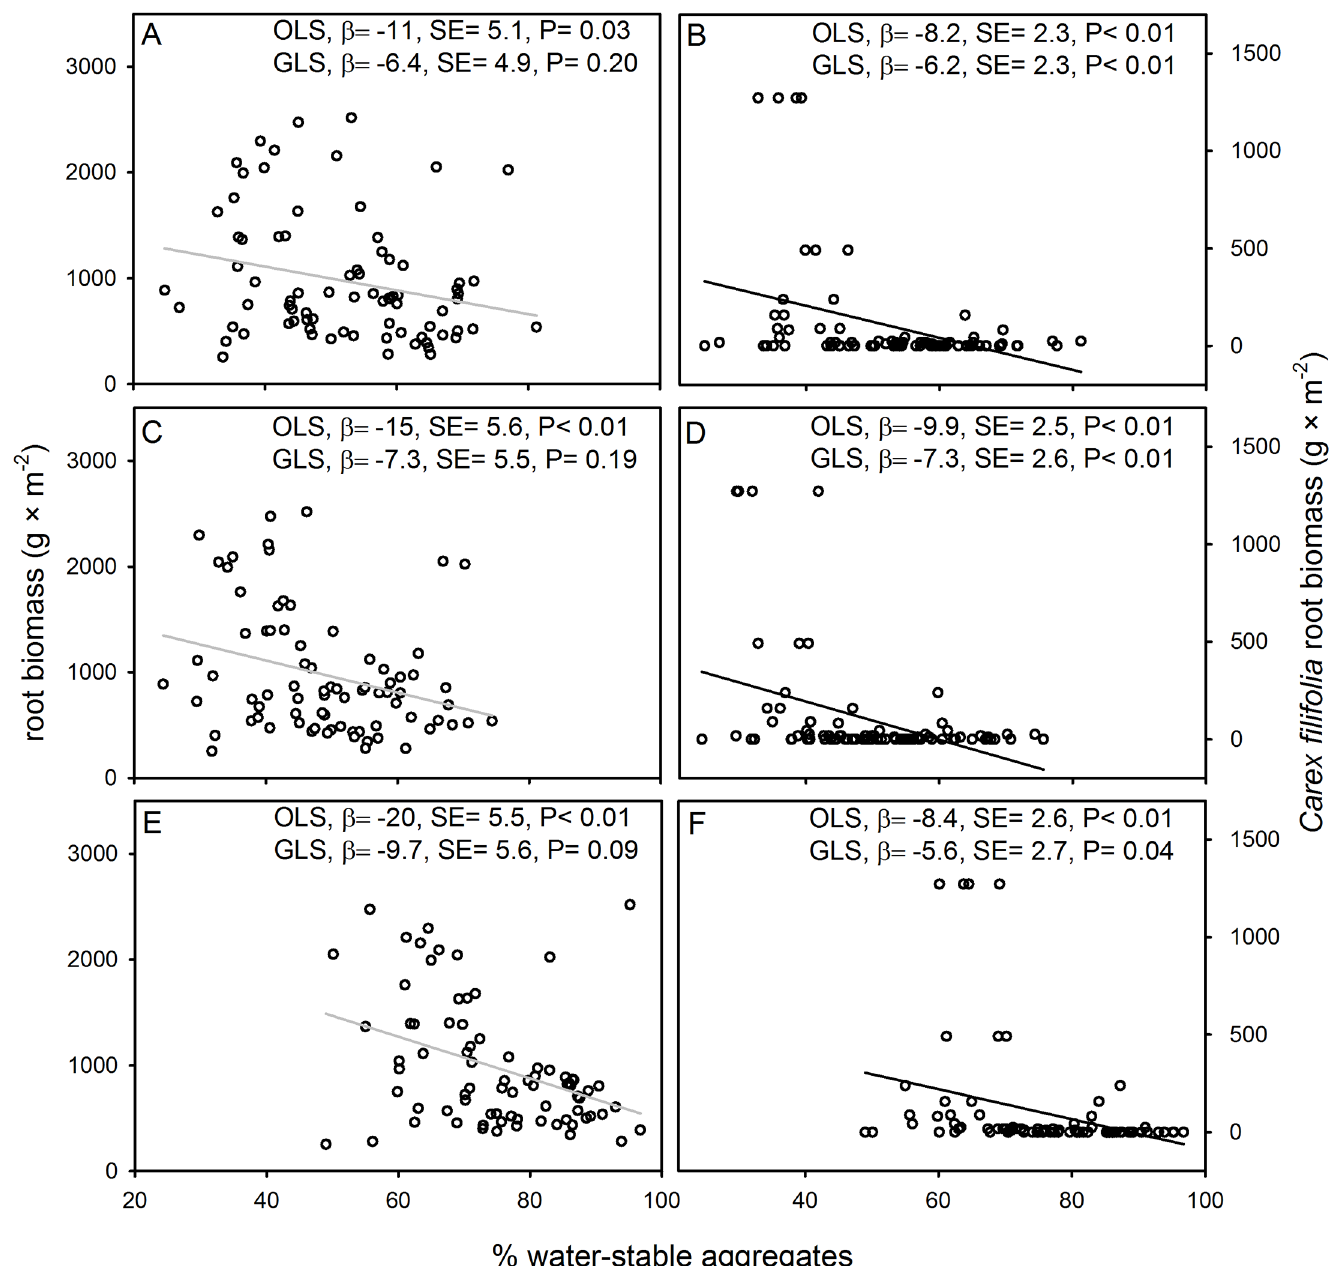
Fig 3. Relationships between % water-stable aggregates and root biomass. Panels show data for either root biomass (A, C, E) (0 – 30 cm soil depth) or Carex filifolia root biomass (B, D, F) (0 – 10 cm soil depth). Panel rows distinguish data for three size classes of macroaggregates: 2 – 4 mm (A,B), 1 – 2 mm (C,D), and 0.25 – 1 mm (E,F) Regression slope coefficients ( β ), standard errors (SE), and p-values are provided for regressions based on ordinary least squares (OLS) and generalized least squares (GLS). Best-fit lines (based on OLS) are black when GLS regressions were significant (P (cid:5) 0.05) or gray when nonsignificant (P >